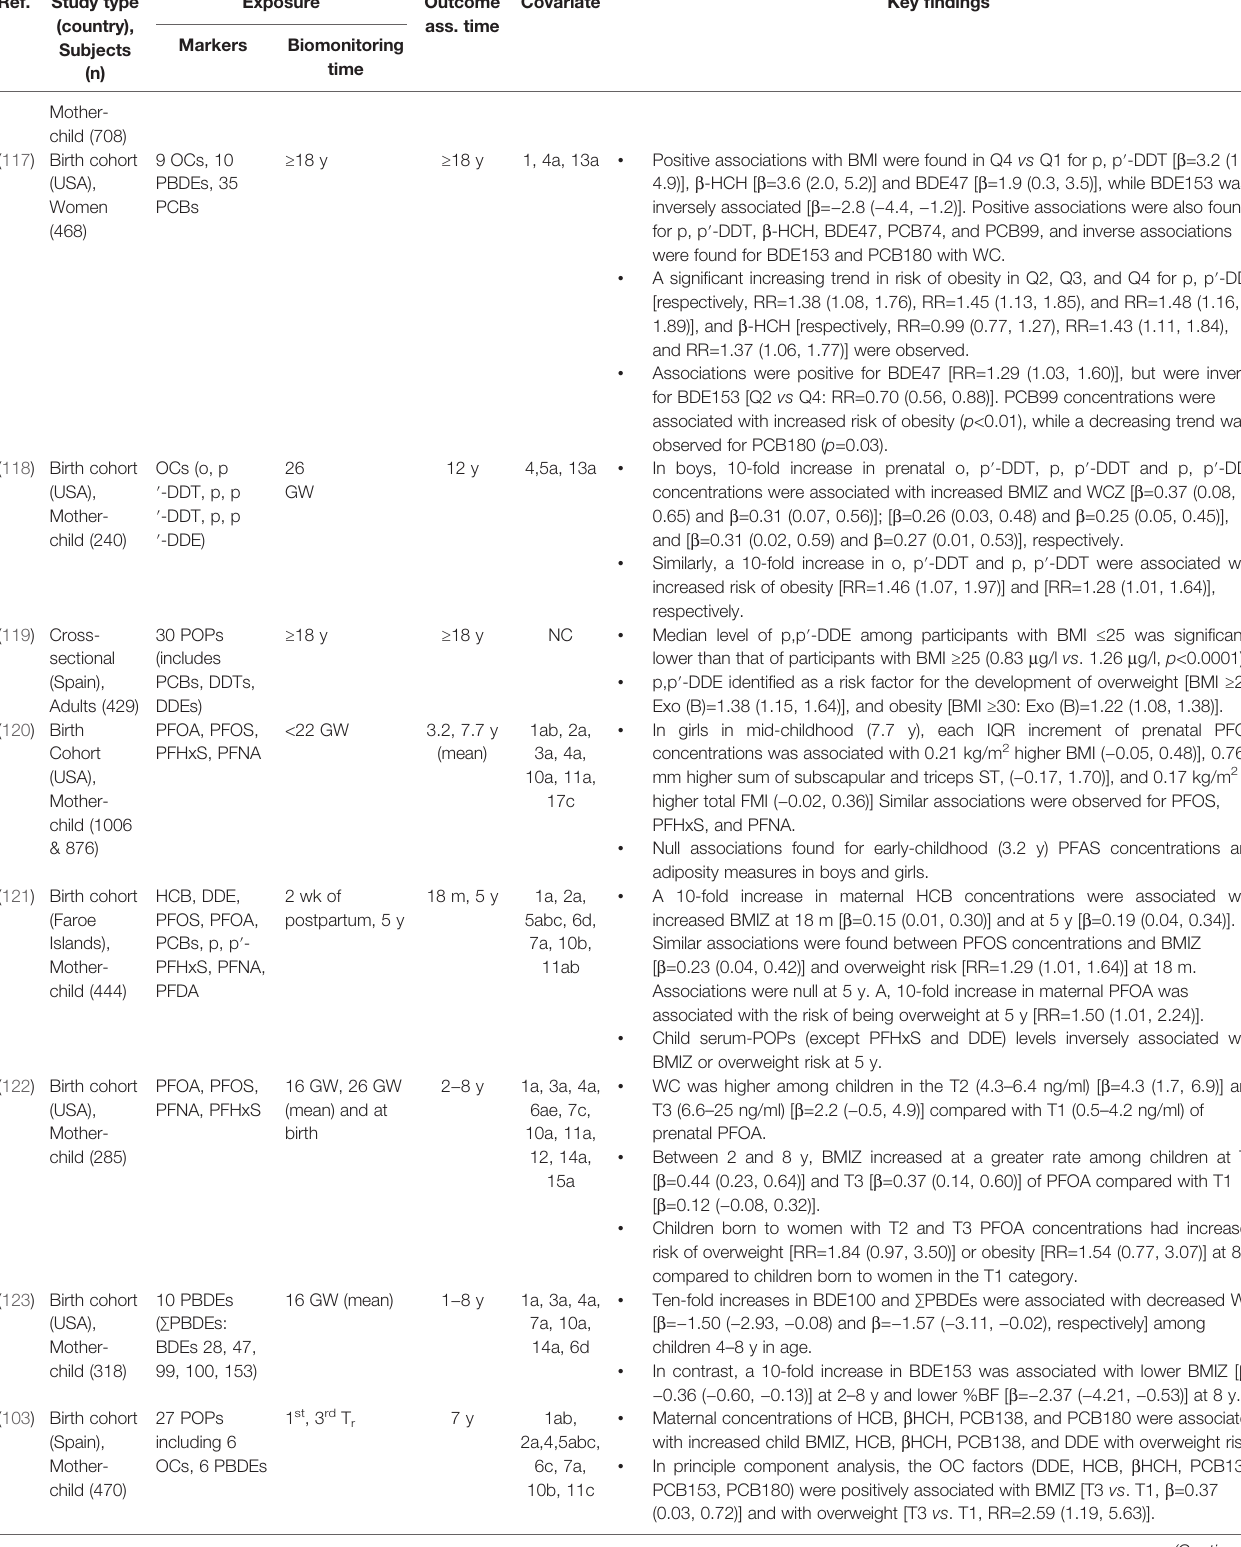
Positive associations with BMI were found in Q4 vs Q1 for p, p ′ -DDT [ b =3.2 (1.5, 4.9)], b -HCH [ b =3.6 (2.0, 5.2)] and BDE47 [ b =1.9 (0.3, 3.5)], while BDE153 was inversely associated [ b = − 2.8 ( − 4.4, − 1.2)]. Positive associations were also found for p, p ′ -DDT, b -HCH, BDE47, PCB74, and PCB99, and inverse associations were found for BDE153 and PCB180 with WC. (cid:129) A signi fi cant increasing trend in risk of obesity in Q2, Q3, and Q4 for p, p ′ -DDT [respectively, RR=1.38 (1.08, 1.76), RR=1.45 (1.13, 1.85), and RR=1.48 (1.16, 1.89)], and b -HCH [respectively, RR=0.99 (0.77, 1.27), RR=1.43 (1.11, 1.84), and RR=1.37 (1.06, 1.77)] were observed. (cid:129) Associations were positive for BDE47 [RR=1.29 (1.03, 1.60)], but were inverse for BDE153 [Q2 vs Q4: RR=0.70 (0.56, 0.88)]. PCB99 concentrations were associated with increased risk of obesity ( p <0.01), while a decreasing trend was observed for PCB180 ( p =0.03). 4,5a, 13a (cid:129) In boys, 10-fold increase in prenatal o, p ′ -DDT, p, p ′ -DDT and p, p ′ -DDE concentrations were associated with increased BMIZ and WCZ [ b =0.37 (0.08, 0.65) and b =0.31 (0.07, 0.56)]; [ b =0.26 (0.03, 0.48) and b =0.25 (0.05, 0.45)], and [ b =0.31 (0.02, 0.59) and b =0.27 (0.01, 0.53)], respectively. (cid:129) Similarly, a 10-fold increase in o, p ′ -DDT and p, p ′ -DDT were associated with increased risk of obesity [RR=1.46 (1.07, 1.97)] and [RR=1.28 (1.01, 1.64)], respectively. (119) Cross- (cid:129) Median level of p,p ′ -DDE among participants with BMI ≤ 25 was signi fi cantly lower than that of participants with BMI ≥ 25 (0.83 m g/l vs . 1.26 m g/l, p <0.0001). (cid:129) p,p ′ -DDE identi fi ed as a risk factor for the development of overweight [BMI ≥ 25: Exo (B)=1.38 (1.15, 1.64)], and obesity [BMI ≥ 30: Exo (B)=1.22 (1.08, 1.38)]. (cid:129) In girls in mid-childhood (7.7 y), each IQR increment of prenatal PFOA concentrations was associated with 0.21 kg/m 2 higher BMI ( − 0.05, 0.48)], 0.76 mm higher sum of subscapular and triceps ST, ( − 0.17, 1.70)], and 0.17 kg/m 2 higher total FMI ( − 0.02, 0.36)] Similar associations were observed for PFOS, PFHxS, and PFNA. (cid:129) Null associations found for early-childhood (3.2 y) PFAS concentrations and adiposity measures in boys and girls. (cid:129) A 10-fold increase in maternal HCB concentrations were associated with increased BMIZ at 18 m [ b =0.15 (0.01, 0.30)] and at 5 y [ b =0.19 (0.04, 0.34)]. Similar associations were found between PFOS concentrations and BMIZ [ b =0.23 (0.04, 0.42)] and overweight risk [RR=1.29 (1.01, 1.64)] at 18 m. Associations were null at 5 y. A, 10-fold increase in maternal PFOA was associated with the risk of being overweight at 5 y [RR=1.50 (1.01, 2.24)]. (cid:129) Child serum-POPs (except PFHxS and DDE) levels inversely associated with BMIZ or overweight risk at 5 y. (cid:129) WC was higher among children in the T2 (4.3 – 6.4 ng/ml) [ b =4.3 (1.7, 6.9)] and T3 (6.6 – 25 ng/ml) [ b =2.2 ( − 0.5, 4.9)] compared with T1 (0.5 – 4.2 ng/ml) of prenatal PFOA. (cid:129) Between 2 and 8 y, BMIZ increased at a greater rate among children at T2 [ b =0.44 (0.23, 0.64)] and T3 [ b =0.37 (0.14, 0.60)] of PFOA compared with T1 [ b =0.12 ( − 0.08, 0.32)]. (cid:129) Children born to women with T2 and T3 PFOA concentrations had increased risk of overweight [RR=1.84 (0.97, 3.50)] or obesity [RR=1.54 (0.77, 3.07)] at 8 y compared to children born to women in the T1 category. (123) Birth cohort (cid:129) Ten-fold increases in BDE100 and ∑ PBDEs were associated with decreased WC [ b = − 1.50 ( − 2.93, − 0.08) and b = − 1.57 ( − 3.11, − 0.02), respectively] among children 4 – 8 y in age. (cid:129) In contrast, a 10-fold increase in BDE153 was associated with lower BMIZ [ b = − 0.36 ( − 0.60, − 0.13)] at 2 – 8 y and lower %BF [ b = − 2.37 ( − 4.21, − 0.53)] at 8 y. Maternal concentrations of HCB, b HCH, PCB138, and PCB180 were associated with increased child BMIZ, HCB, b HCH, PCB138, and DDE with overweight risk. (cid:129) In principle component analysis, the OC factors (DDE, HCB, b HCH, PCB138, PCB153, PCB180) were positively associated with BMIZ [T3 vs . T1, b =0.37 (0.03, 0.72)] and with overweight [T3 vs . T1, RR=2.59 (1.19,